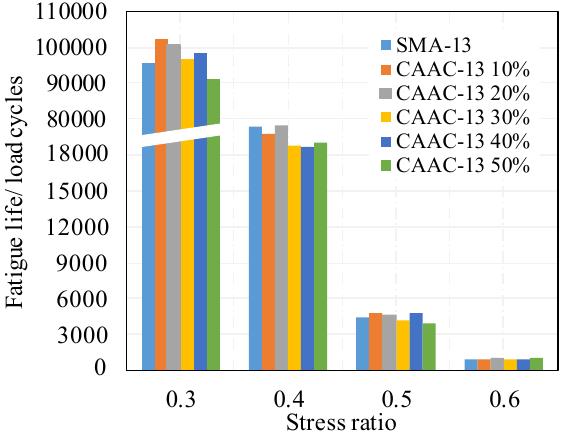
Figure 10. Fatigue life of beams at different stress ratios.